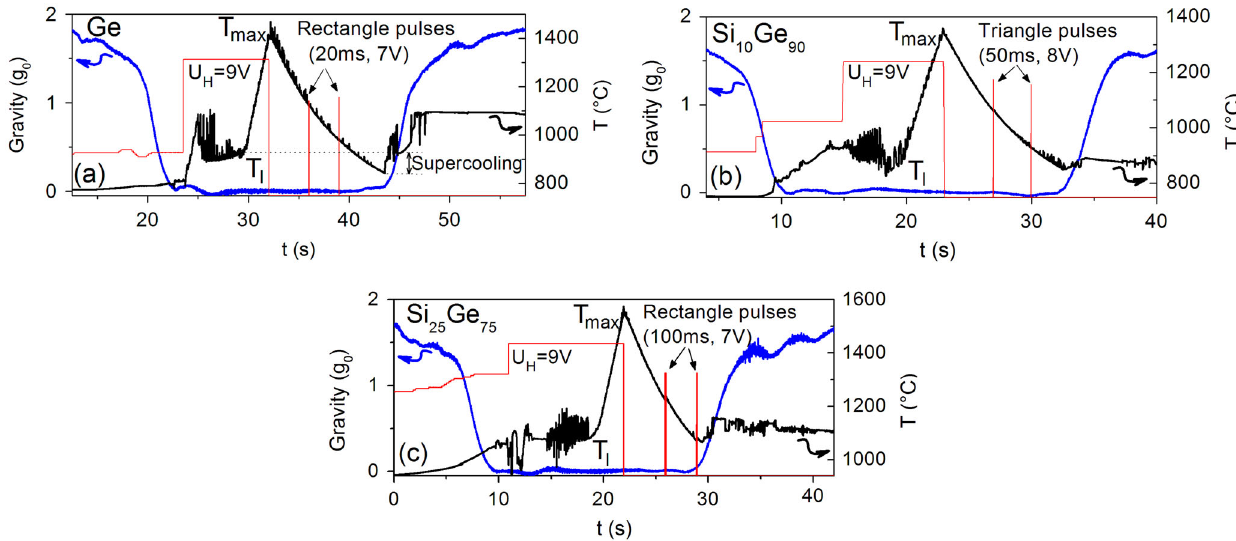
Fig. 3 Time pro fi les of the μg-levels ( blue ), the heating voltages ( red ) as a measure of the magnetic fi eld strength and the temperatures ( black ) measured for doped Ge ( a ), Si 10 Ge 90 ( b ), and Si 25 Ge 75 ( c ). For the excitation of drop oscillations various pulse shapes ( red ) were used.